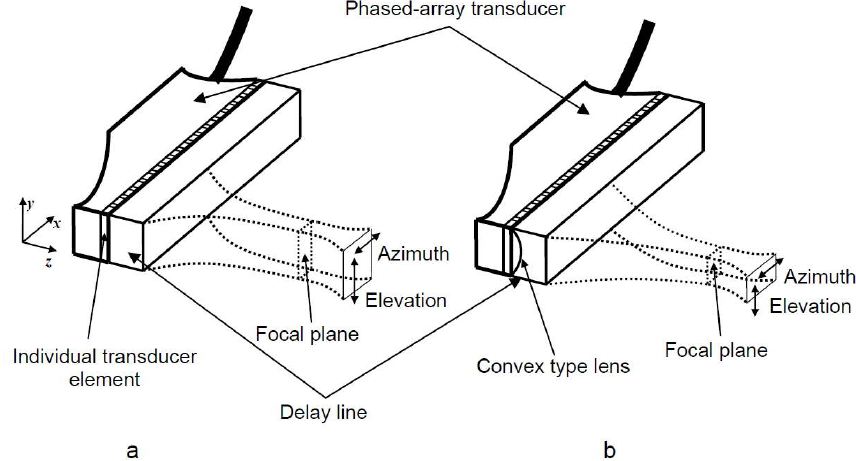
Figure 1. Focusing of the ultrasonic phased array transducer using the different types of the delay line: in azimuth cross-section only ( a ), in azimuth cross-section and in elevation cross-section with convex lens ( b ).